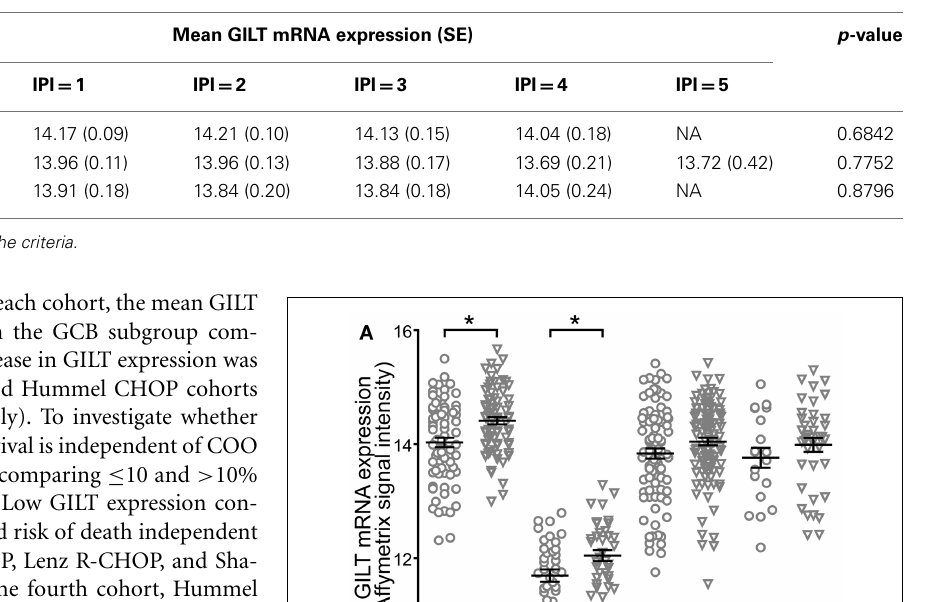
Table 2 | GILT expression is not associated with IPI score .